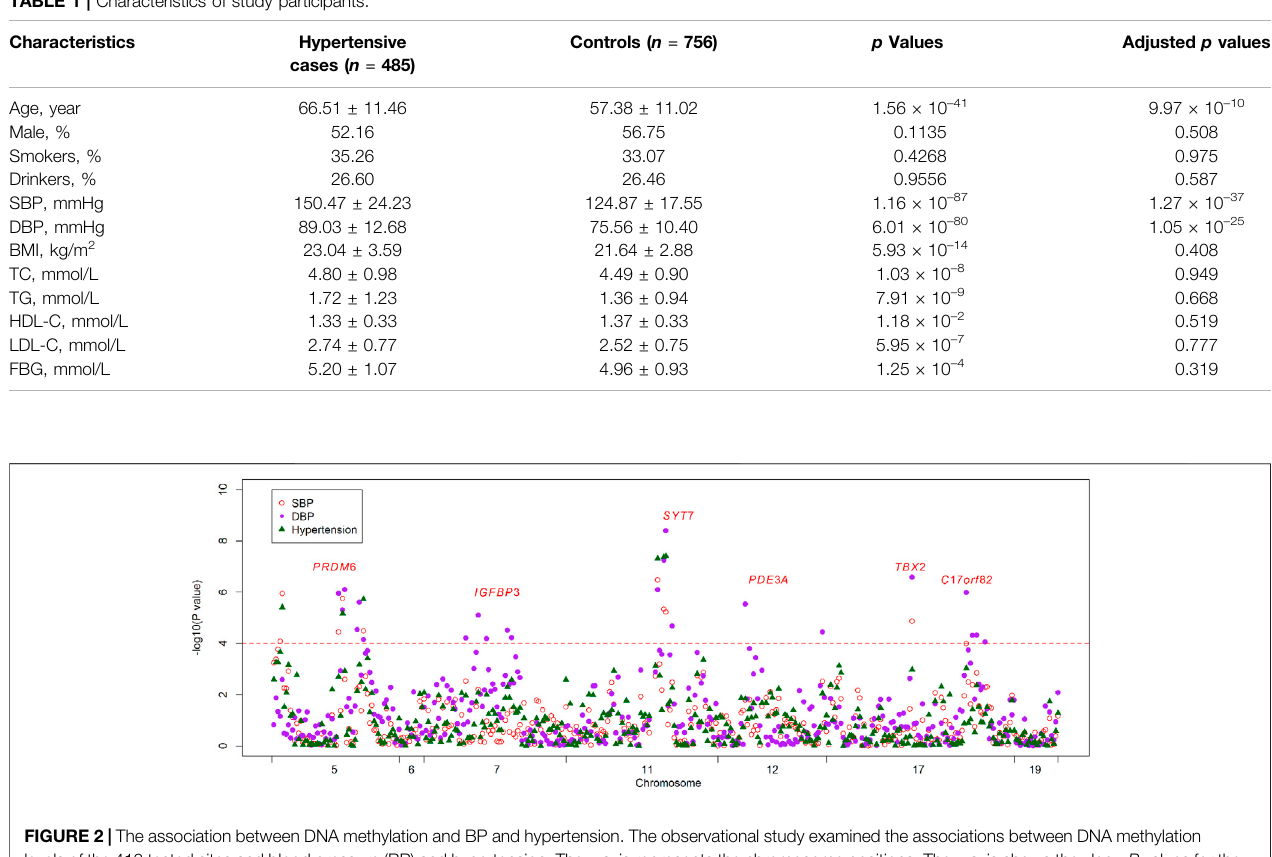
FIGURE 2 | The association between DNA methylation and BP and hypertension. The observational study examined the associations between DNA methylation levels of the 413 tested sites and blood pressure (BP) and hypertension. The x -axis represents the chromosome positions. The y -axis shows the – log 10 P values for the associationsbetweenmethylationlevelsandSBP(redcircles),DBP(purpledot)andhypertension(greentriangles).Twenty-foursitesatsixgenesachievedathresholdof 1.0 × 10 – 4 (red